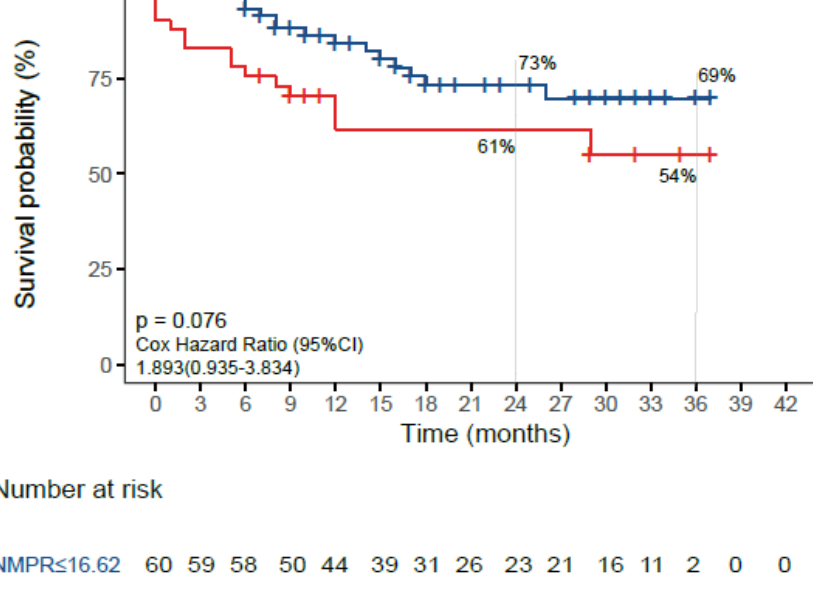
Figure 3. Kaplan–Meier curves for PFS or OS according to NMPR in the training cohort ( A ) and the external validation cohort ( B , C ). PFS, progression-free survival; OS, overall survival; NMPR, neutrophil–mean-platelet-volume–platelet ratio.